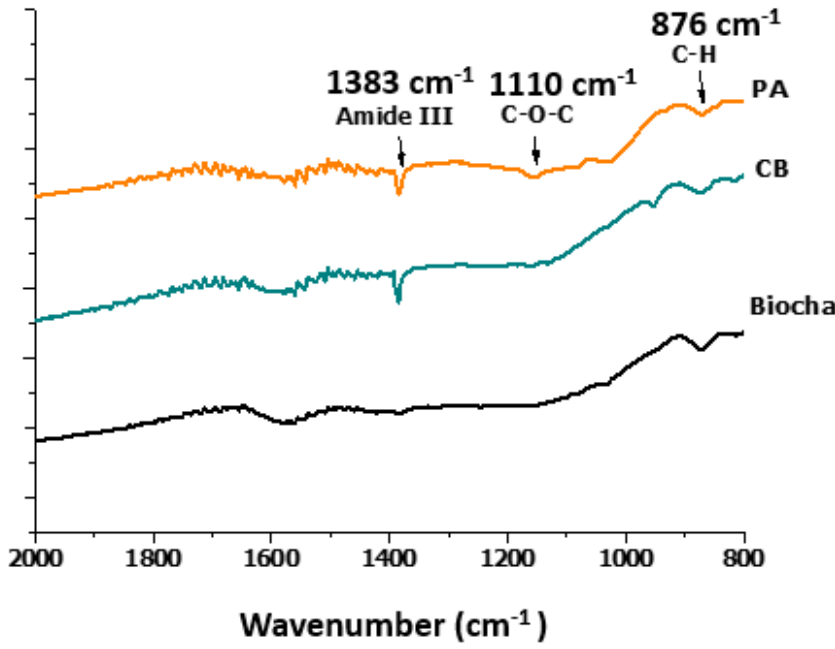
Figure 9. FTIR spectrum for biochar and biocatalysts immobilized by PA and CB .